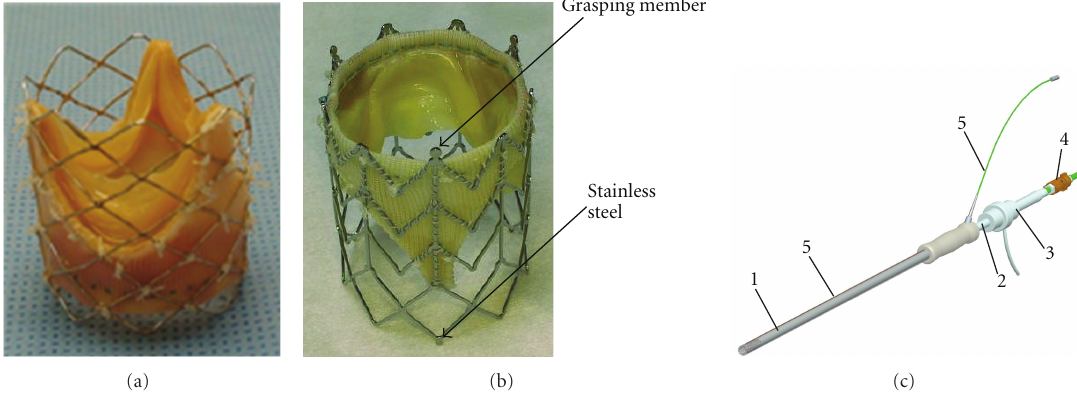
Figure 1: Devices: (a) balloon-expandable prosthesis. (b) Self-expanding prosthesis, a Medtronic Freestyle valve sewn inside the Nitinol self- expanding stent. A small stainless steel welded on the small round extension of distal end of the stent serves as a passive marker indicating the orientation of the prosthesis. The grasping member of the proximal end is used for retrieve and reposition of the stent. (c) A CAD drawing of the delivery device with loop coil and antenna. Sheath with handle (1) protects and retains the prosthesis compressed until the deployment. Inner rod with handle (2) pushes the prosthesis for deployment. Inner channel of the inner rod provides access for the loop snare wire (4). End spacer with dimension protection (3) protects the end valve and ensures the exact dimension for the loop snare wire. The loop coil antenna (5) is fixed into the groove cut on exterior tube of valve delivery system. The delivery device is made of nylon and